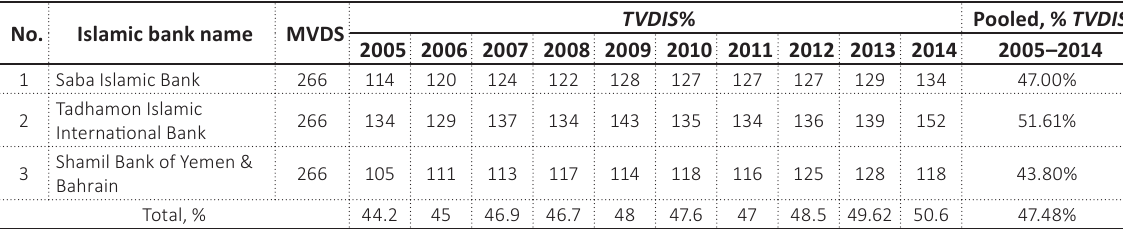
Table 3. TVDIS for each Islamic bank over the ten years (2005–2014)